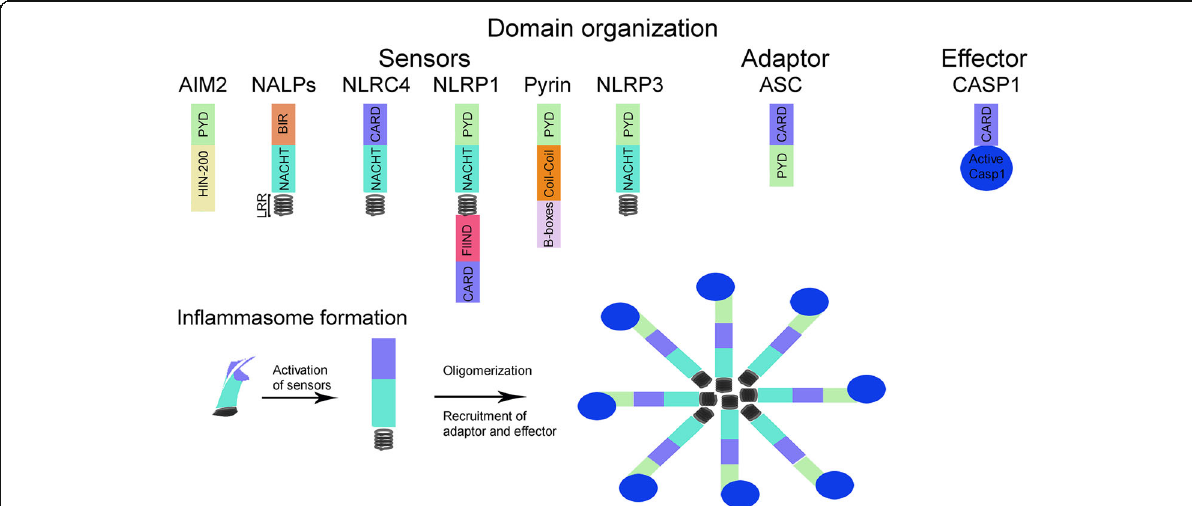
Fig. 1 Simplified scheme of inflammasome elements, types and formation. Domain organization and basic inflammasome formation. At the molecular level, assembly of inflammasome signaling complexes is mediated through interactions between homotypic protein domains. The domains of AIM2, NALPs, NLRC4, NLRP1, Pyrin, NLRP3, ASC, and CASP1 are shown here. The inflammasome is composed of a sensor, adaptor, and effector protein. Several inflammasomes contain a PYD, responsible for the recruitment of the adaptor protein ASC. After activation, inflammasomes using this adaptor interact with ASC through PYD – PYD interactions, forming large, filamentous oligomers. ASC then recruits CASP1 across CARD – CARD interactions. NLRP1 and NLRC4 may directly interact with CASP1 by CARD – CARD interactions, though these NLRs could also interact with ASC via CARD – CARD interactions. After activation, the sensor oligomerizes and recruits the adaptor and effector proteins to the inflammasome complex. ASC, apoptosis-associated speck-like protein containing a caspase recruitment domain; AIM2, absent in melanoma 2; BIR, baculoviral inhibitor of apoptosis protein repeat; FIIND, function-to-find domain; CARD, caspase recruitment domain; CASP, caspase; LRR, leucine-rich repeat; NALP, Nucleotide-binding oligomerization domain, Leucine-rich Repeat and Pyrin domain containing; NLRC4, NLR family CARD domain-containing protein 4; NLRP1, nucleotide-binding domain (NOD)-like receptor family pyrin domain containing 1; NLRP3,